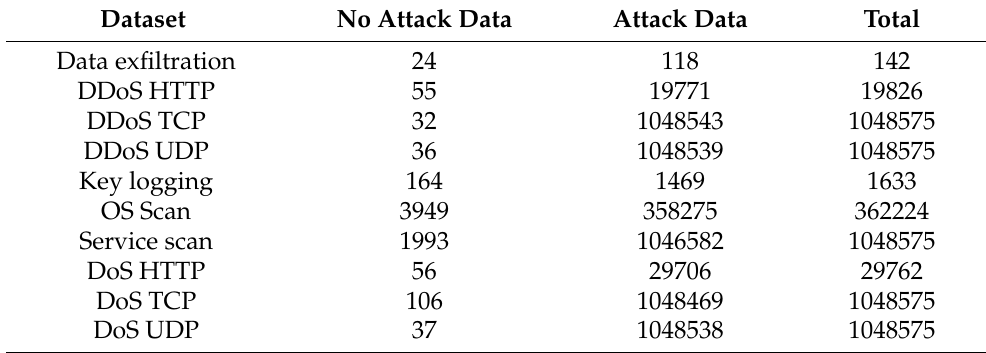
Table 5. Dataset label distribution.